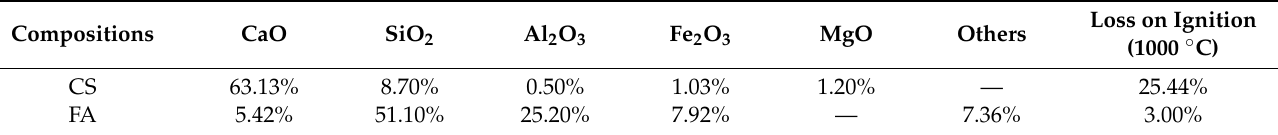
Table 1. Chemical compositions of carbide slag (CS) and fly ash (FA) by X-ray fluorescence.